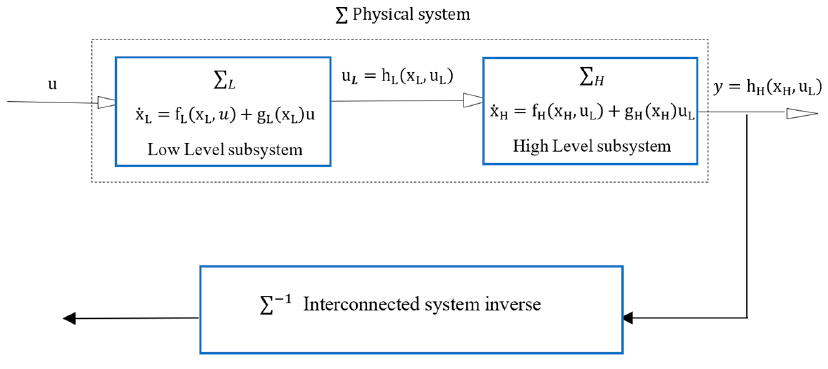
Figure 2. The inverse of an interconnected system.